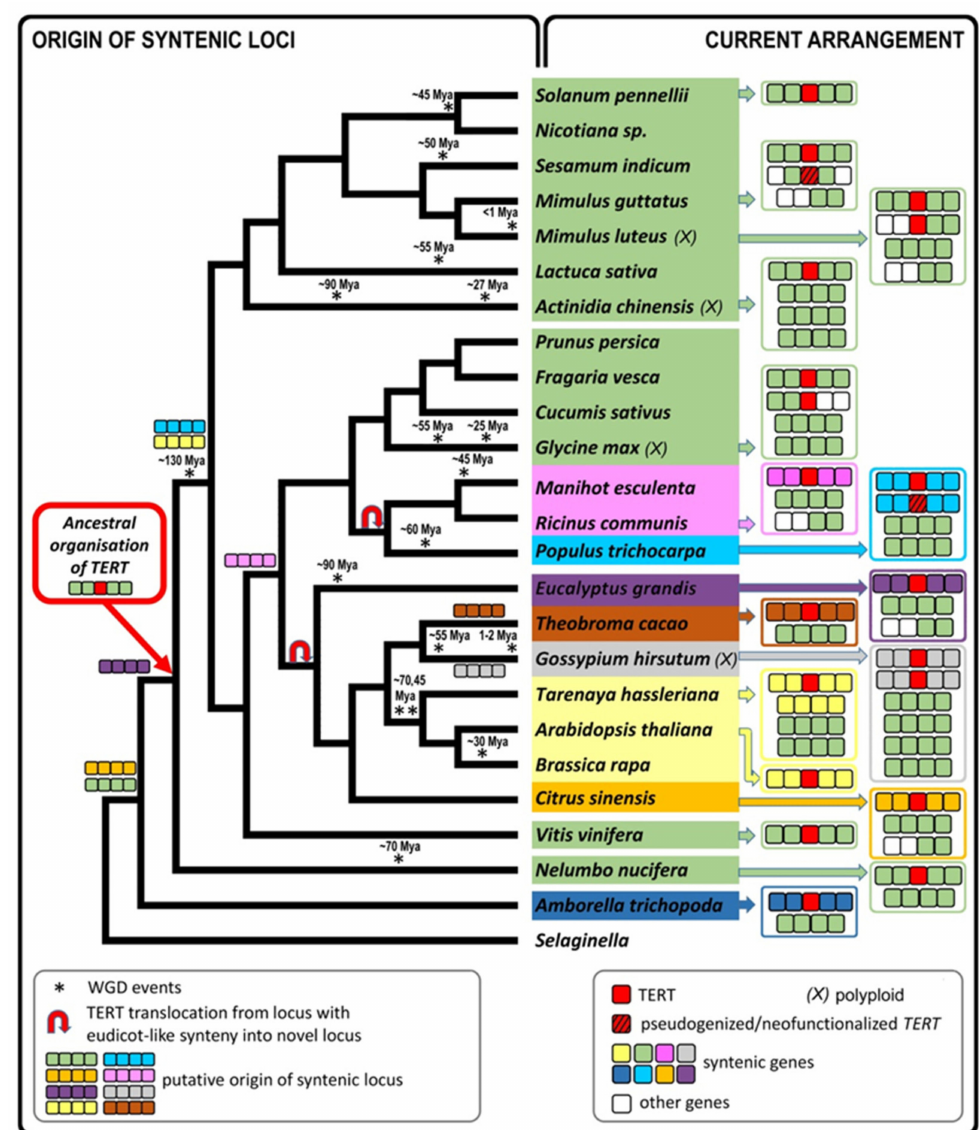
Figure 7. Origin of syntenic TERT loci in angiosperms. An ancestral locus with eudicot-like synteny that is present in the Amborella genome adopted the TERT gene in basal eudicots ( Nelumbo ). This ancestral locus with eudicot-like synteny occurs within the genomes of eudicots with the exception of the model plant Arabidopsis thaliana (for simplicity, diagrams on right panels show occurrence and arrangement of loci with eudicot-type synteny and with a specific synteny if present). The TERT gene was translocated several times into novel loci with a conserved synteny observed in current species (termed here as Citrus -like, Populus -like, Eucalyptus -like, Ricinus -like, Arabidopsis -like syntelogs) that had already occurred in ancestors (nodes depicting synapomorphic relationships of specific synteny-types and thus the putative origin of ancestral syntenic loci are shown above respective phylogeny nodes). As an exception, Malpighiales ( Theobroma , Gossypium ) show the TERT gene translocated into novel species-specific loci. These genomes nevertheless still contain the ancient loci with conserved synteny (details in Figure 6). TERT is mostly maintained as a single copy gene, but polyploid species can tolerate more copies ( M. luteus , G. max , G. hirsutum are shown as representatives). Copies of genomic loci with the original synteny remain present after TERT gene elimination, e.g., in Actinidia chinensis , where it is difficult to distinguish which of the ohnologous loci (ohnologs = paralogs derived by WGD) have lost their TERT gene copy (see Supplemental Text S1, Figure S2). Phylogeny was adapted from APG IV [52], WGDs were mapped according to [7] in eudicots, and according to [53] in Actinidia